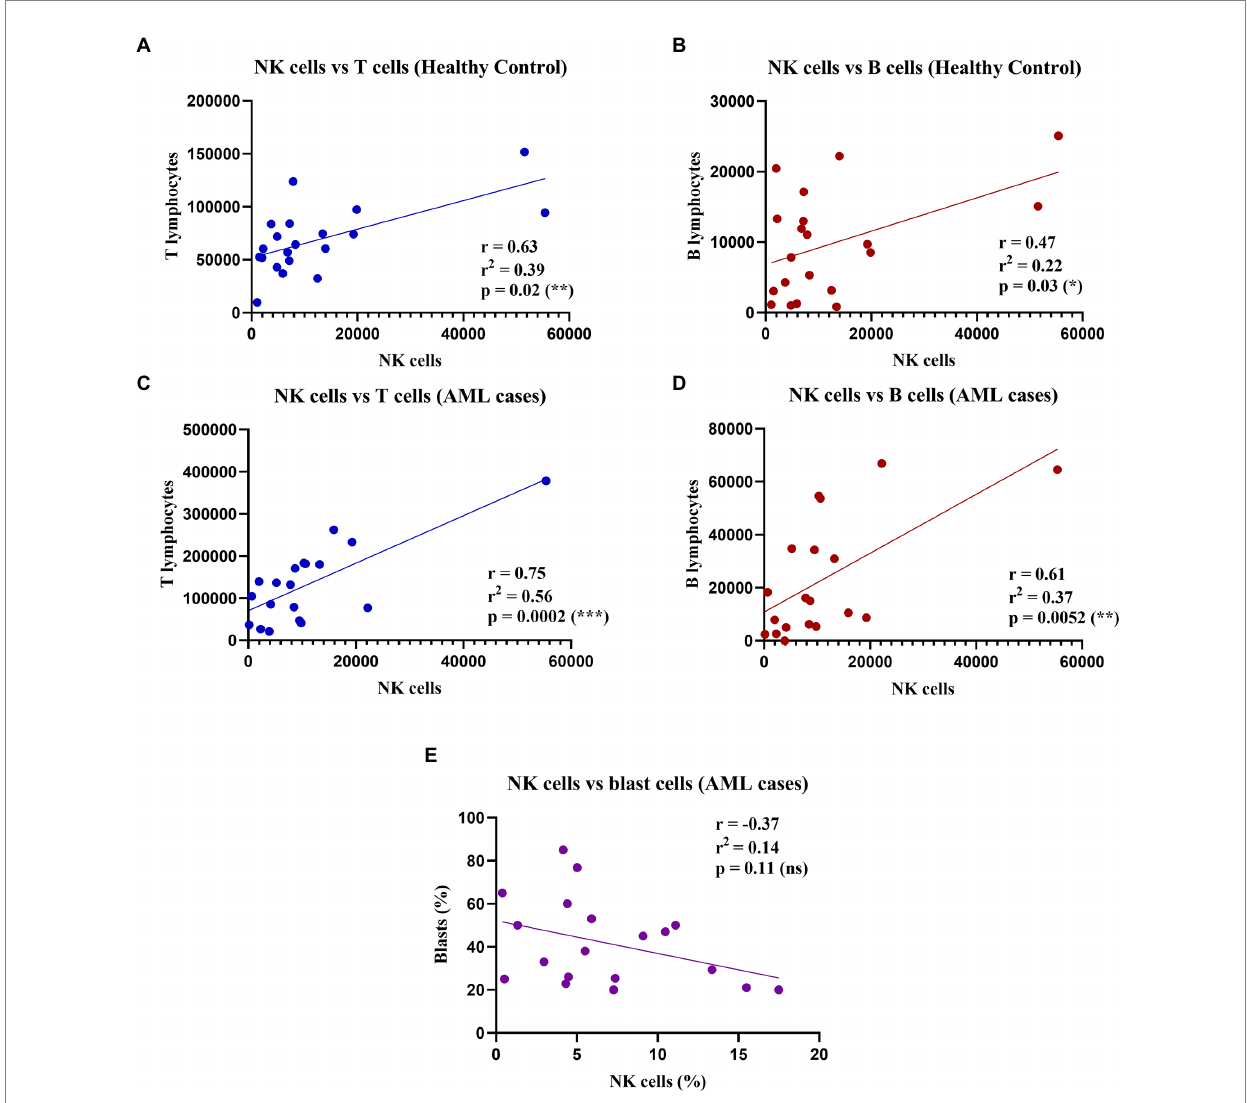
FIGURE 2 Correlations between NK, T, and B cell counts in healthy control and AML cases. (Top) Linear regressions for the healthy control group: (A) Between NK cells and T cells ( n = 20); p = 0.02 (*). (B) Between NK cells and B cells ( n = 20); p = 0.03 (*). Bottom linear regression for the AML group: (C) Between NK cells and T cells ( n = 19); p = 0.0002 (***). (D) Between NK cells and B cells ( n = 19; p = 0.005 (**). (E) Between percentages (%) of NK cells and (%) blast cells ( n = 19; ns, not